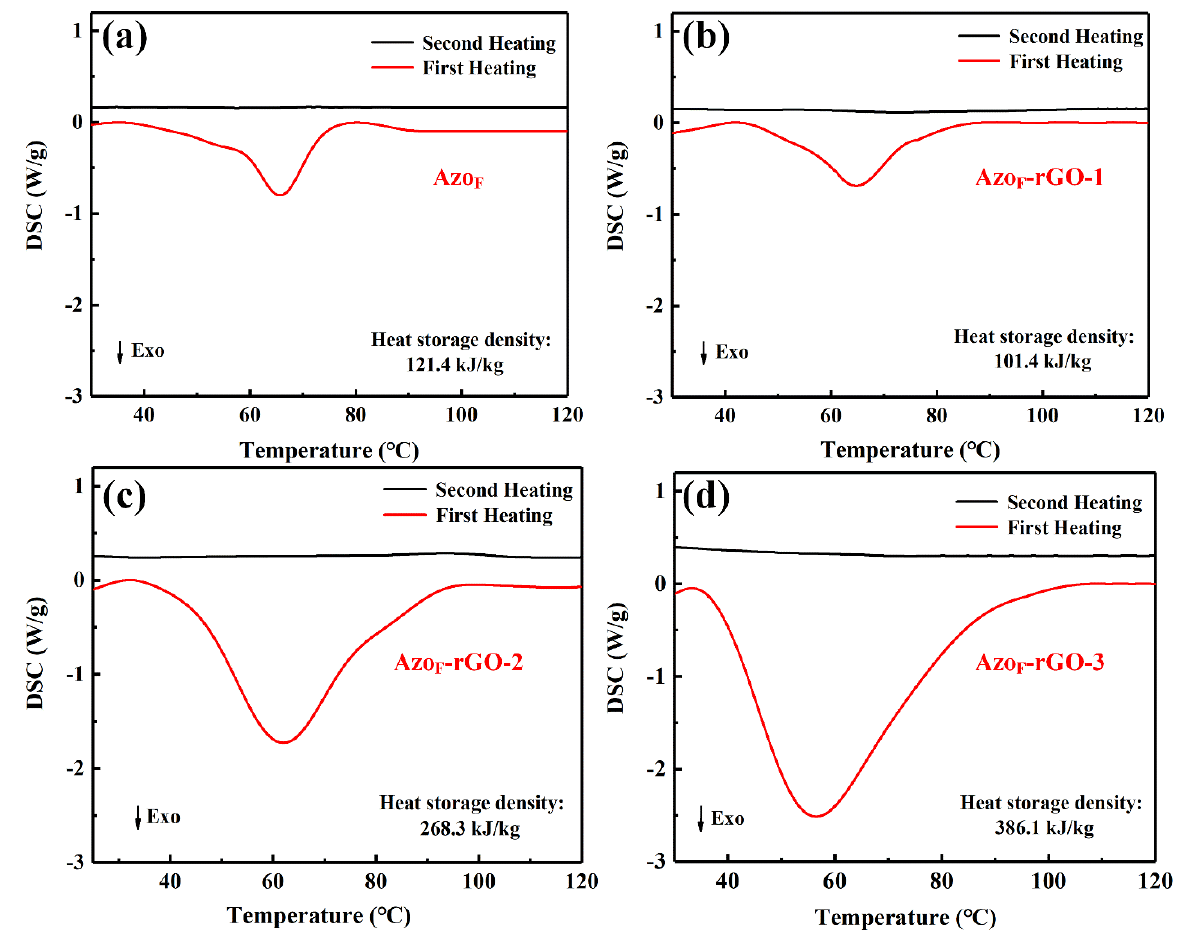
Figure 5. DSC (differential scanning calorimetry) traces of ( a ) Azo F and ( b – d ) Azo F -rGO after 1, 2 and 3-times reaction.